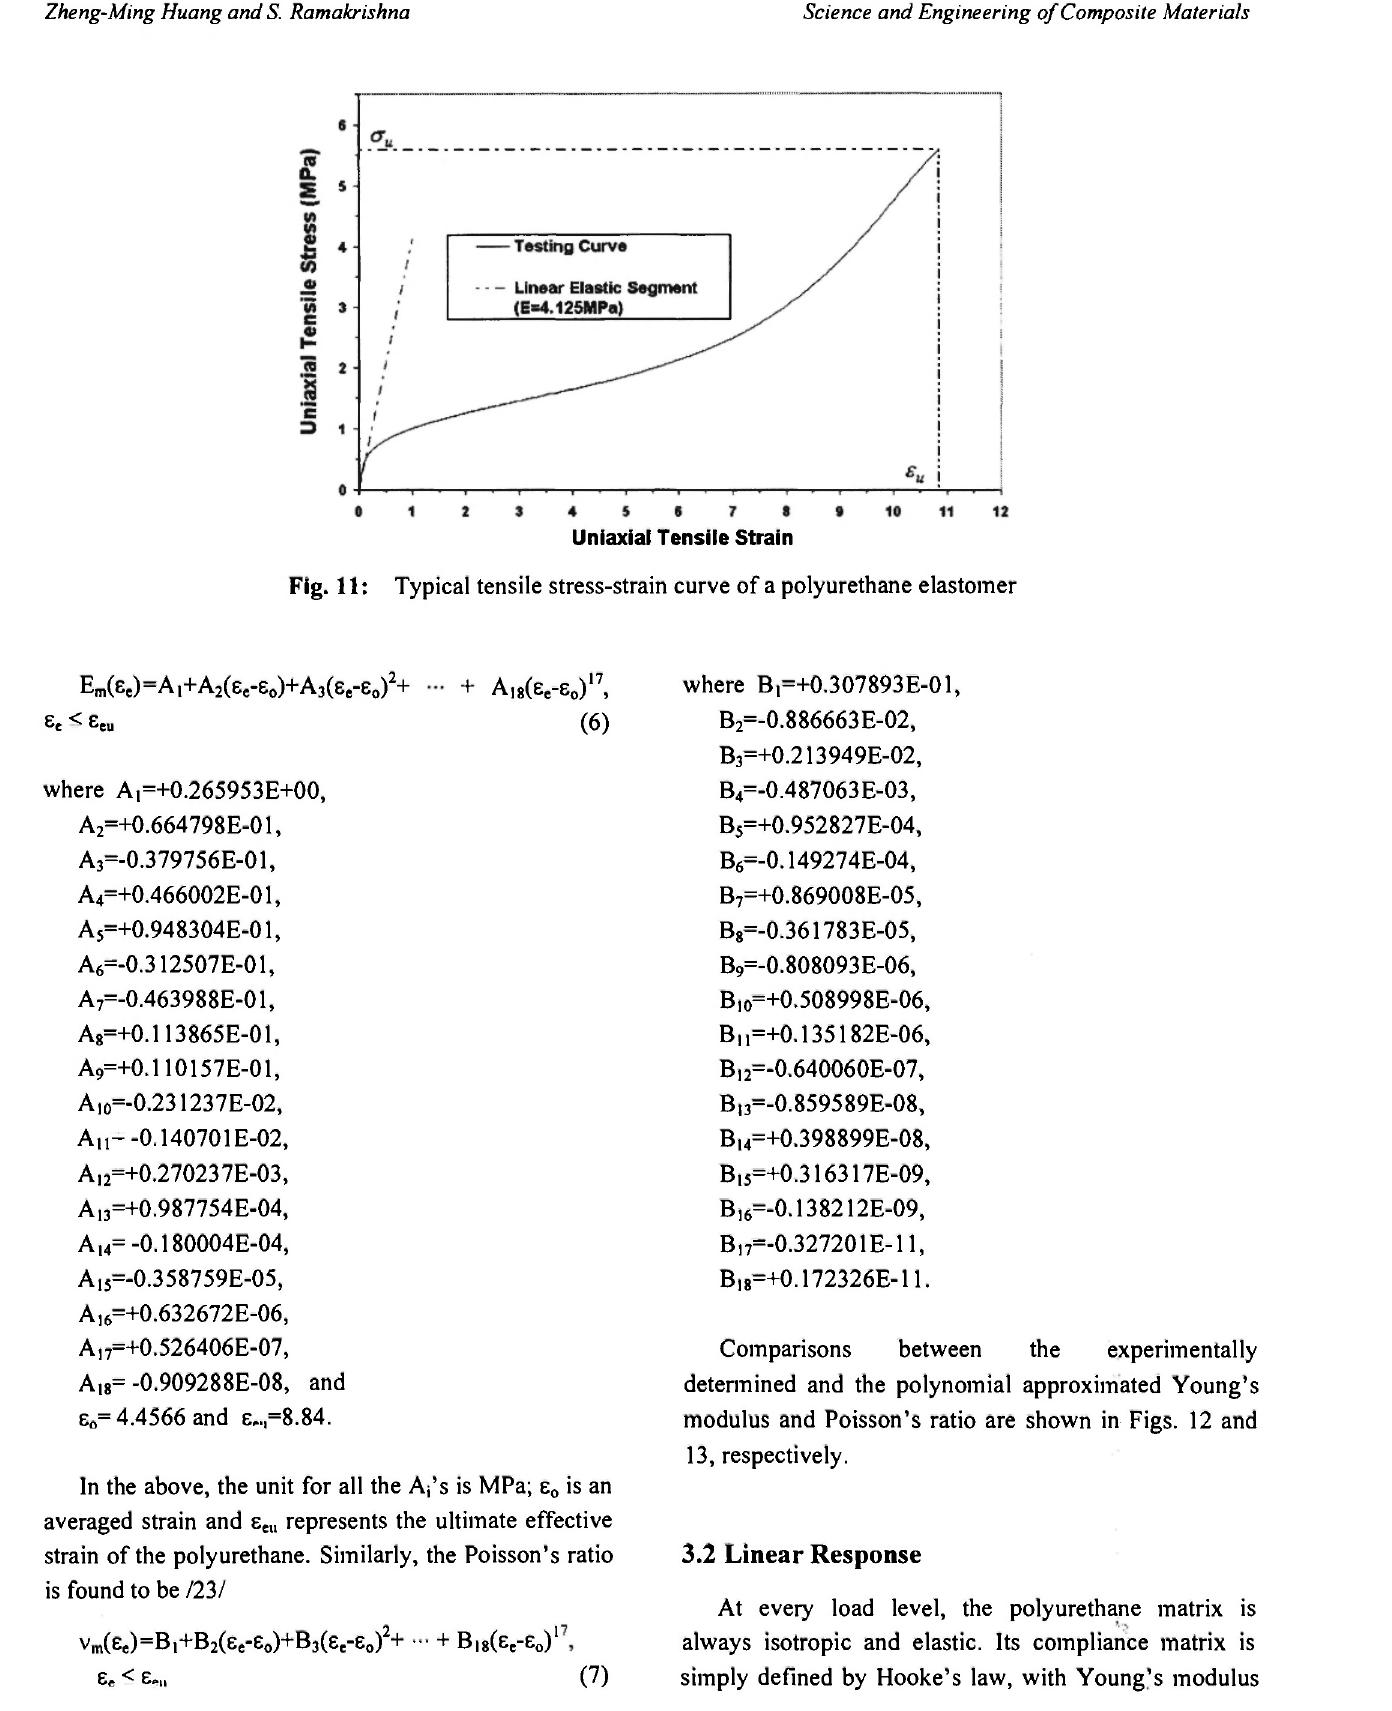
+ Α 18 (ε 6 -ε 0 ) 17 ,